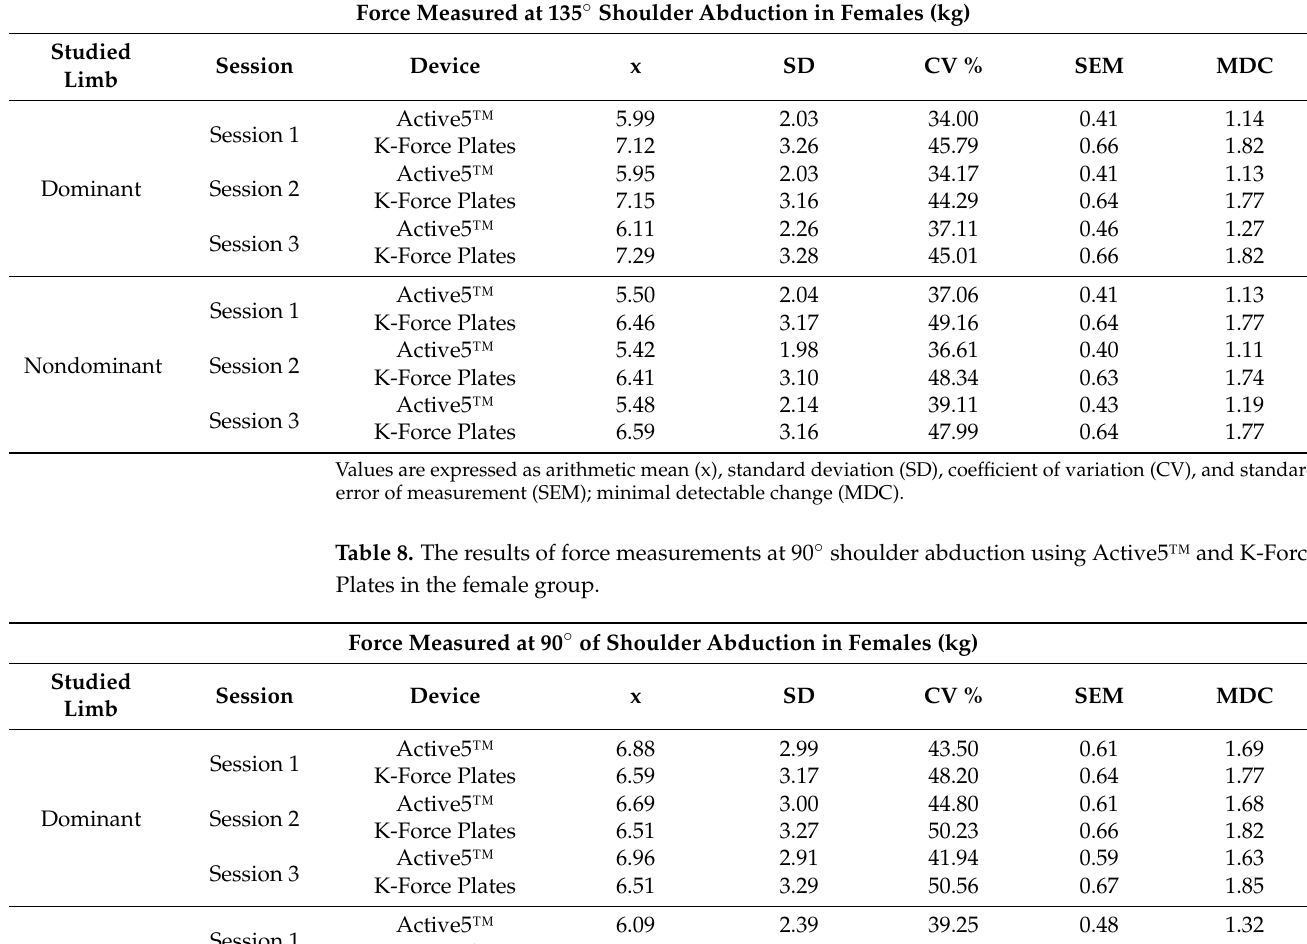
Table 7. The results of force measurements at 135 ◦ shoulder abduction using Active5™ and K-Force Plates in the female group.